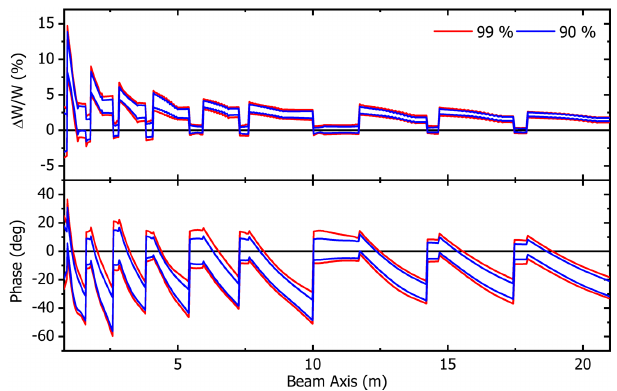
FIG. 19. Gap voltage (top) and on-axis maximum gap field distribution along the CH-DTL and including the 33 MeV rebuncher.